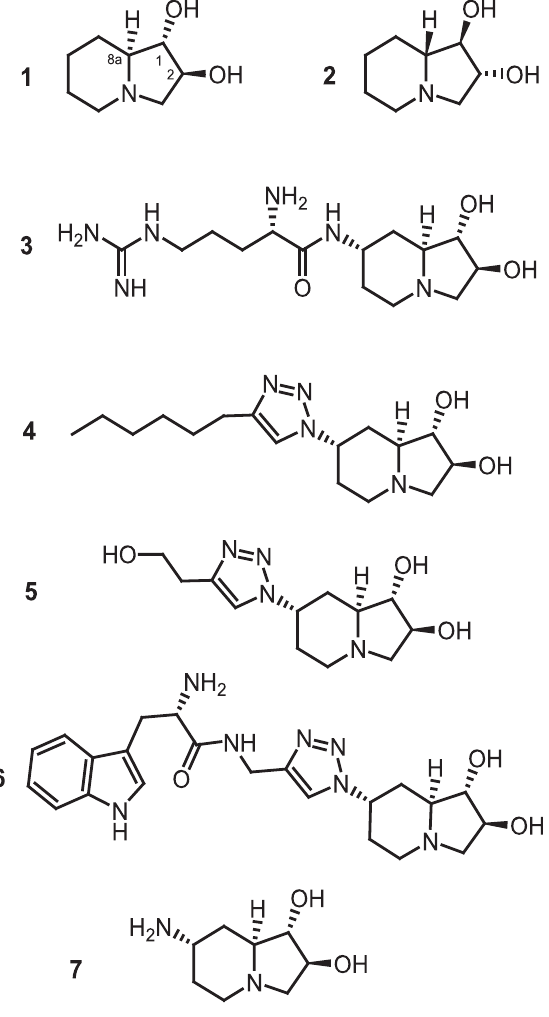
Figure 1. Structure of compounds 1–7.